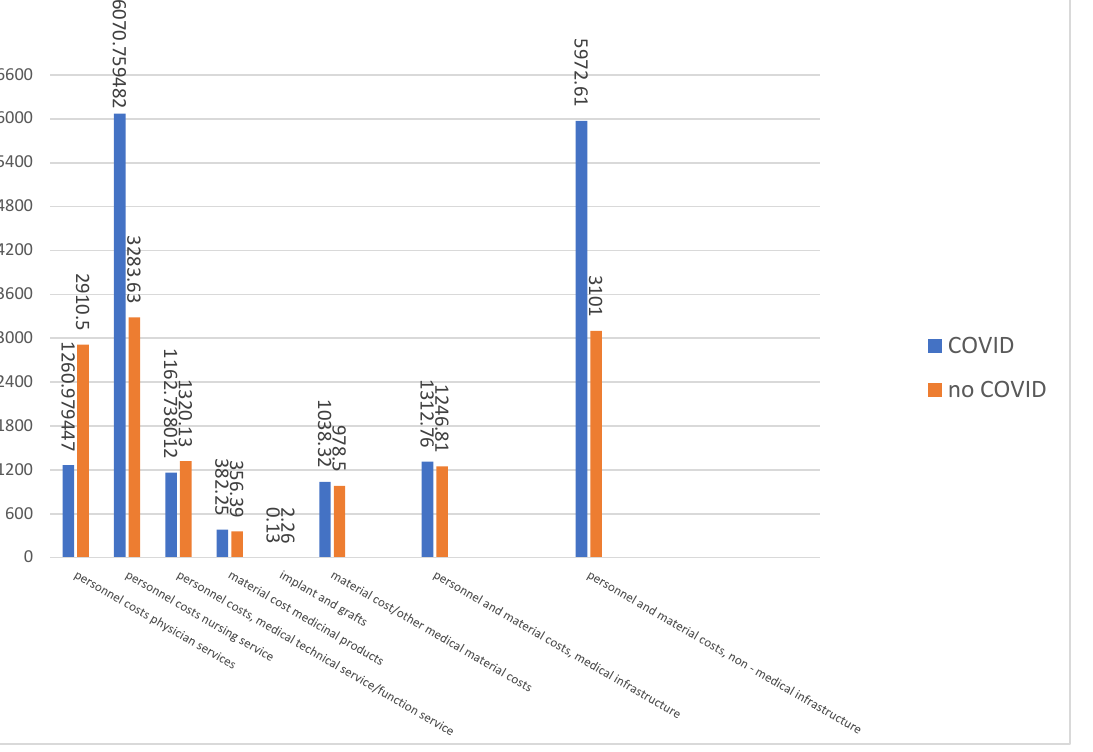
Figure 2. Comparison of total costs of inpatient treatment with and without COVID- 19 (in €) .